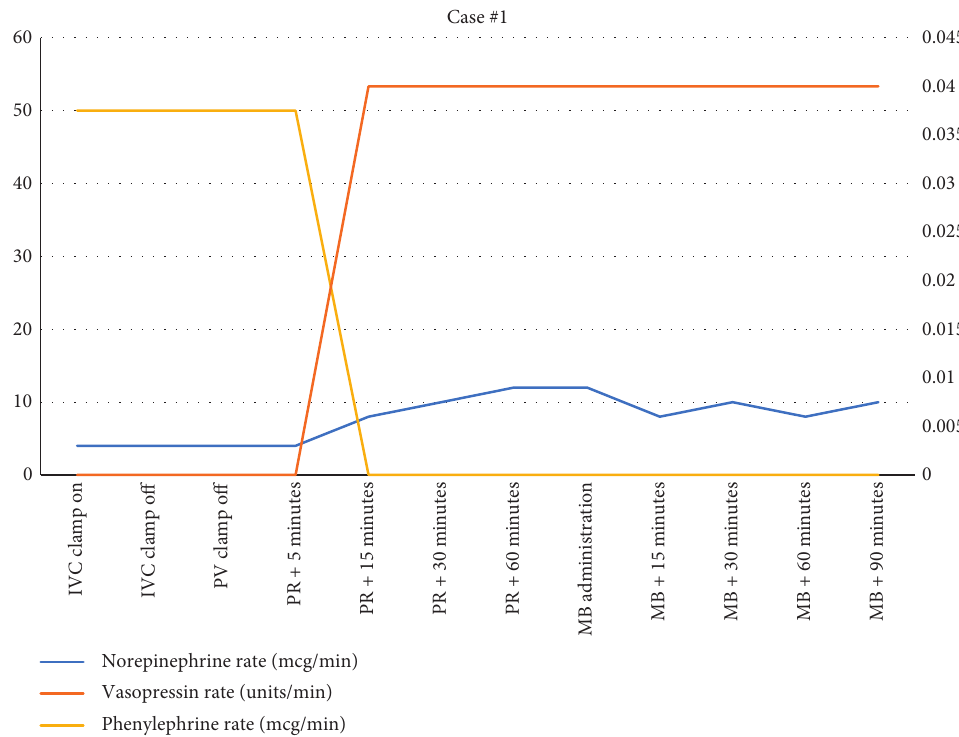
Figure 2: Vasoactive medication use during case #1.